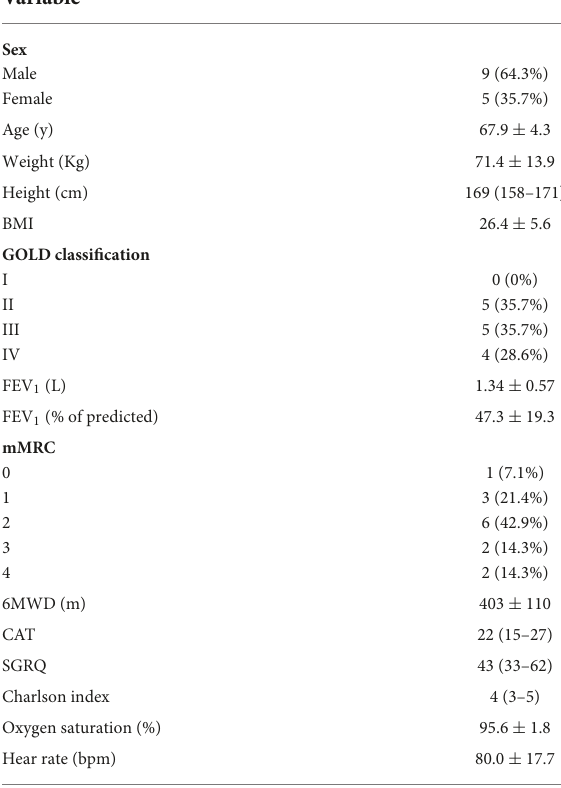
TABLE 1 Baseline characteristics.